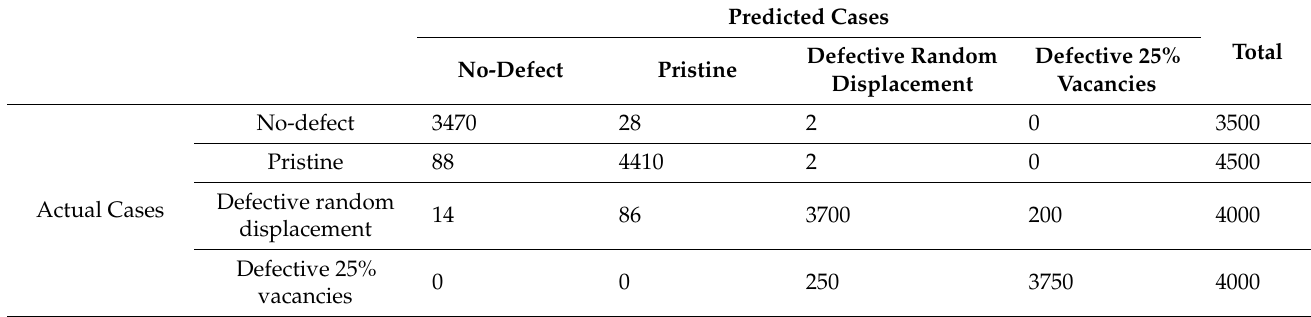
Table 1. Exper-1confusion matrix for Dns-Net without the transfer learning.